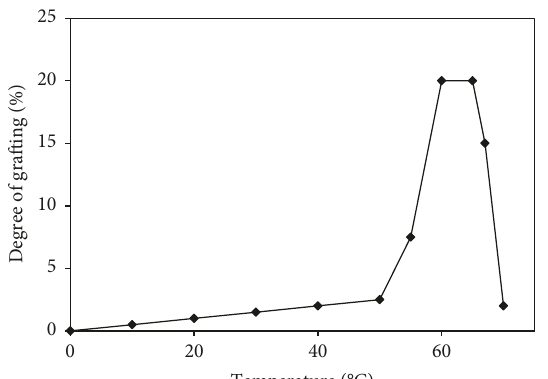
Figure 7: Effect of temperature on the degree of grafting on PVC by N -PhIM. Monomer concentration of 3mol/L × 10 − 1 ; initiator concentration of 1.5mol/L × 10 − 2 for 17 h.